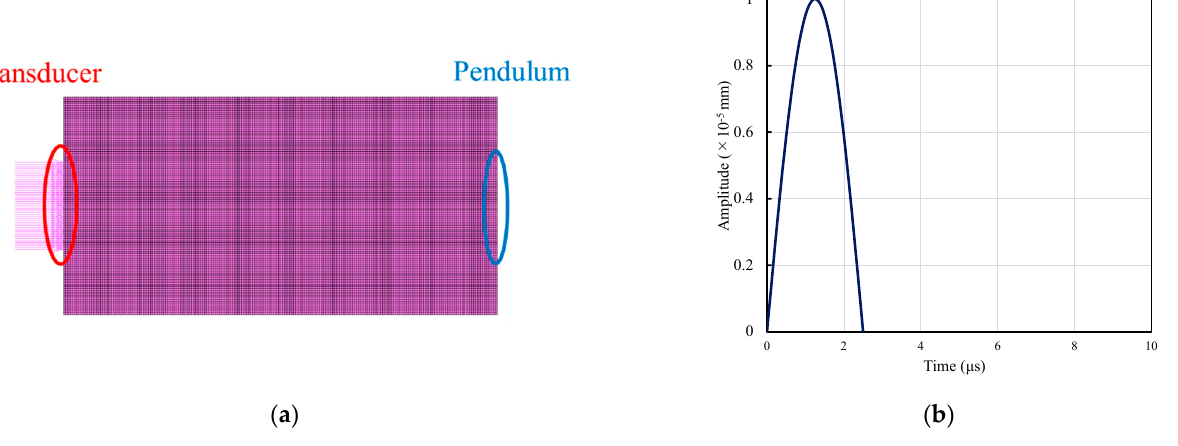
Figure 7. Analysis condition: ( a ) Model and ( b ) Input waveform.